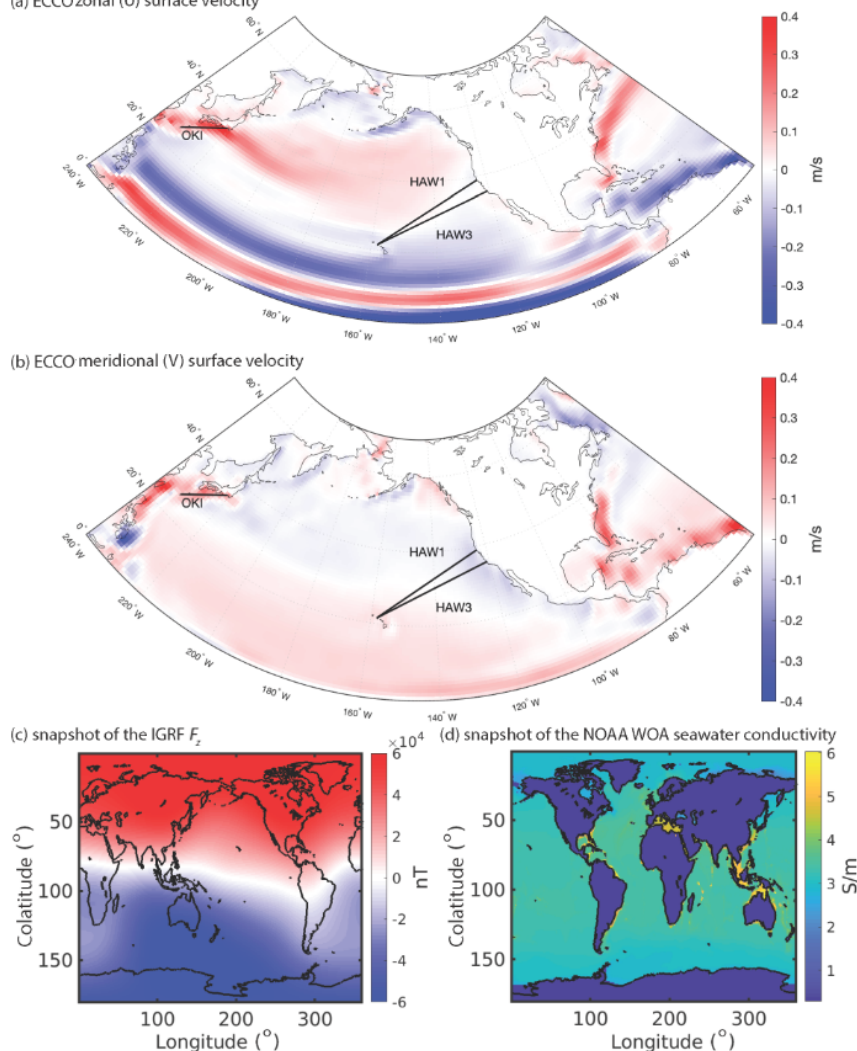
Figure 3. The surface velocities from ECCO are shown (a) for the zonal ( U ) component and (b) for the meridional ( V ) component. The labeled, thick black lines denote the seafloor voltage cables used in this study. A snapshot of the IGRF vertical main field, F z , from 17 Jan- uary 1997 is illustrated in panel (c) , and panel (d) depicts the NOAA World Ocean Atlas seawater electrical conductivity’s January climatol- ogy in the surface